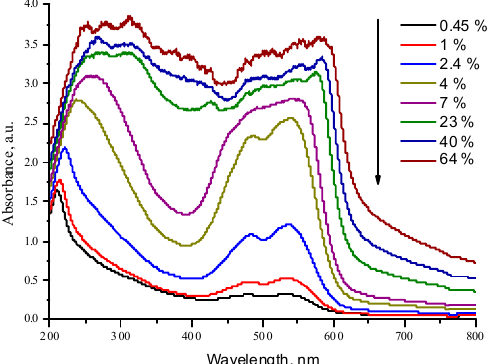
Figure 4. UV-VIS spectra of diluted beetroot juice.